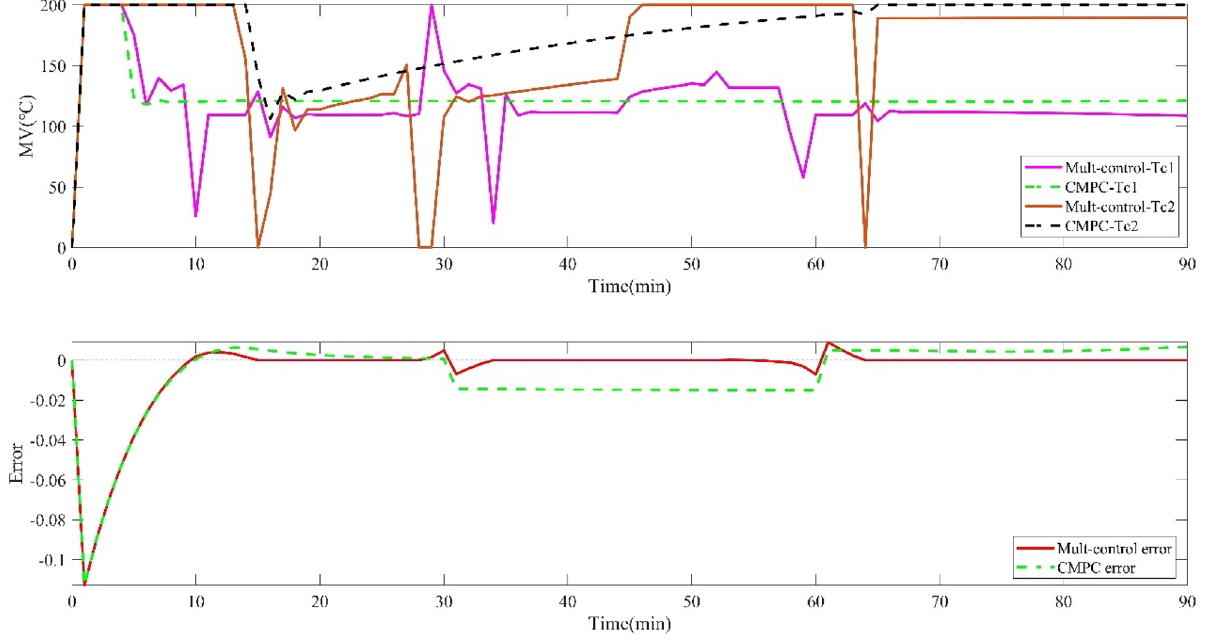
Figure 3. Operation variables of drying process and outlet moisture error of cutting-tobacco under nominal